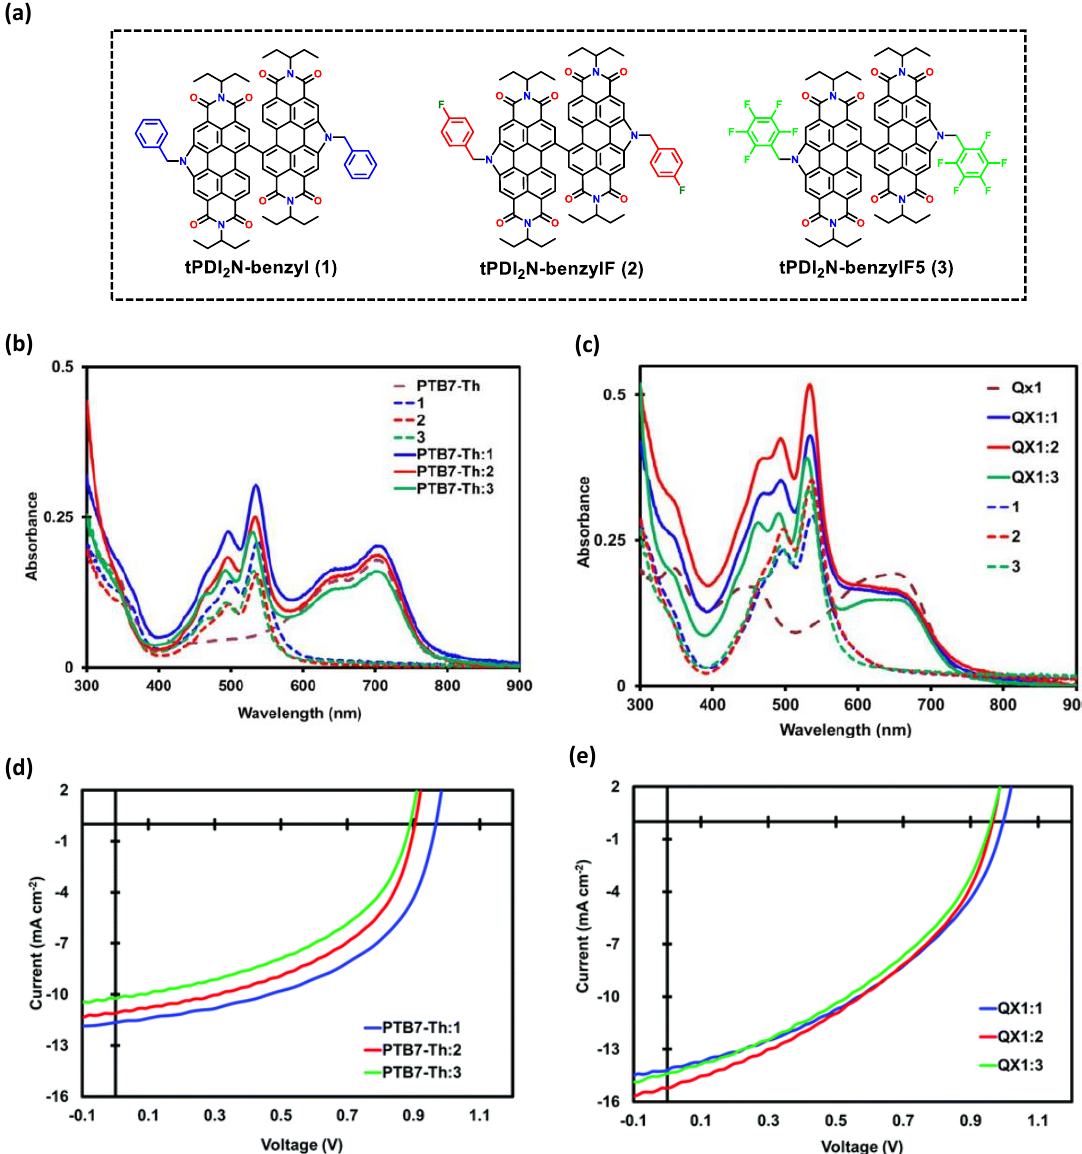
Figure 10. ( a ) Chemical structure of tPDI 2 N-benzyl ( 1 ), tPDI 2 N-beznylF ( 2 ), and tPDIN 2 -beznylF5 ( 3 ), ( b ) UV–Vis absorption spectra of the neat PTB7-Th, neat PDI 1–3 , and BHJ blends, ( c ) UV–Vis absorption spectra of the neat QX1, neat PDI 1–3 , and BHJ blends, ( d ) device J – V curves of PTB7-Th: PDI 1–3 blends (1:1), and ( e ) device J – V curves of QX1: PDI 1–3 blends (1:1.5) [98]. ( b – e ) reproduced with permission from [98]. Copyright 2018 Royal Society of Chemistry.